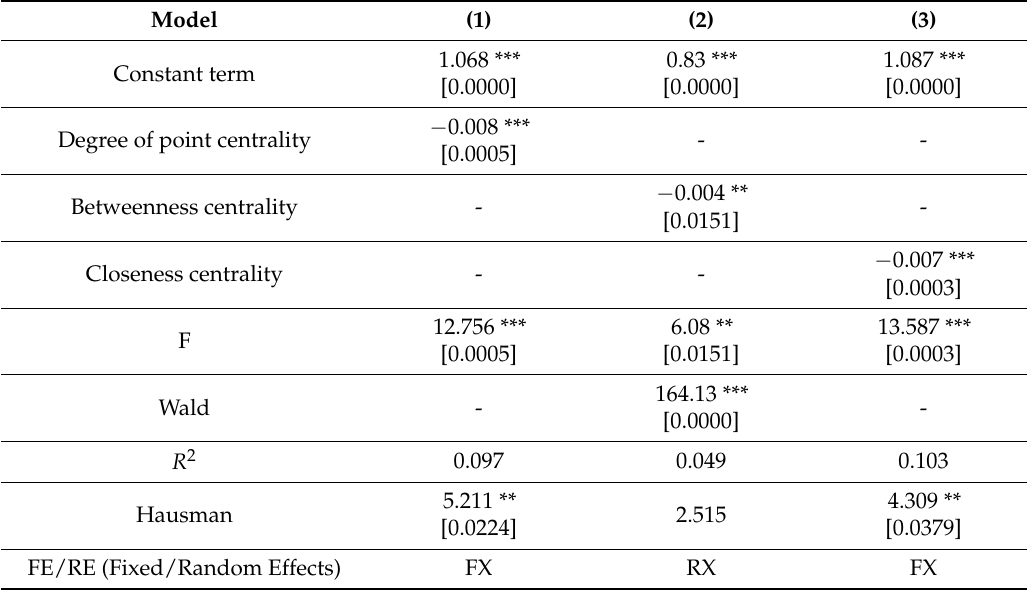
Table 4. Panel data regression results of network